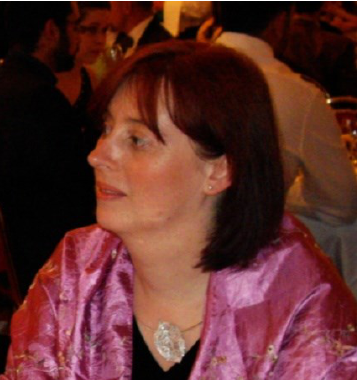
Figure 11. Magdalena F. Chadzińska at the 11th Congress of the International Society for Comparative & Developmental Immunology, Prague (Czech Republic) in 2009. She obtained her Ph.D. degree in Evolutionary Immunobiology from the Jagiellonian University, Kraków (Poland) in 1995. A DSc degree (“Habilitation”) for her work on “Opioid System and Innate Immunity” from the same university followed in 2009. Between 1995 and today, she went through the ranks from assistant to associate professor at the Institute of Zoology of the Jagiellonian University. Since 2011, she has been the Head of the Department of Evolutionary Immunology, Institute of Zoology. In 2012 she became Council member of the European Society for Comparative Endocrinology. She has published excellent papers on neuro-immune modulation, innate immunity, inflammation, and the biology of macrophages and neutrophils in amphibia, fish (Atlantic salmon, carp, goldfish), and